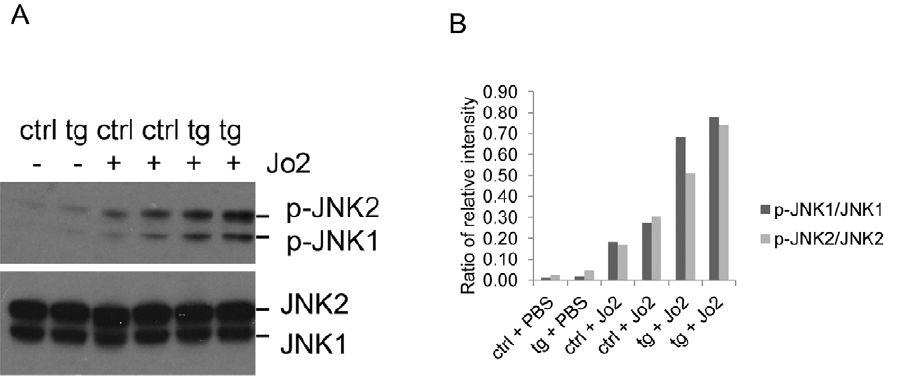
Figure 4. Fas-mediated activation of JNK in HBV transgenic mice. (A) Western blot analysis of activation of JNK in HBV transgenic mice and control mice. i.v. injected with PBS or anti-Fas antibody Jo2. (B) Quantification of activation of JNK1 and JNK2 in HBV transgenic mice and control mice as described in (A).